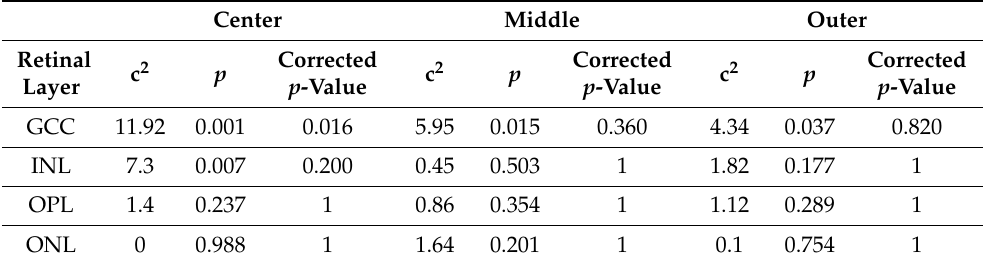
Table 2. Comparison of model fit for the baseline and full model using likelihood ratio test between the LHON and nonLHON group showing the significant differences between LHON and nonLHON group in the thickness of the GCC in the ETDRS center in favor of the LHON group. Center Middle Outer Retinal Corrected Layer p -Value